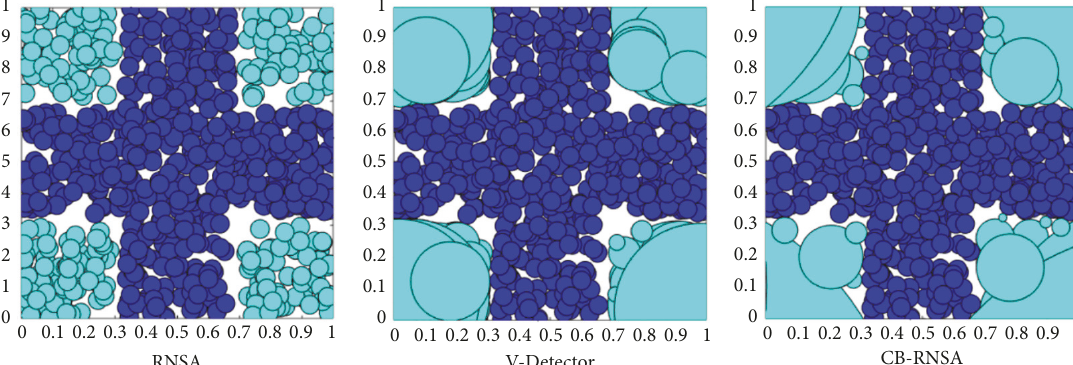
Figure 13: Comparisons of RNSA, V-Detector, and CB-RNSA in Cross (to achieve the expected coverage rate 90%, RNSA, V-Detector, and CB-RNSA need 289, 61, and 37 mature detectors, respectively, where the training set size is 500, the self radius is 0.03, and the detector radius of RNSA is 0.03).